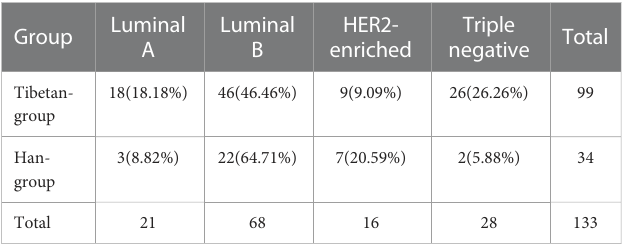
TABLE 3 Molecular subtypes in Tibetan-group and Han-group [n (%)].